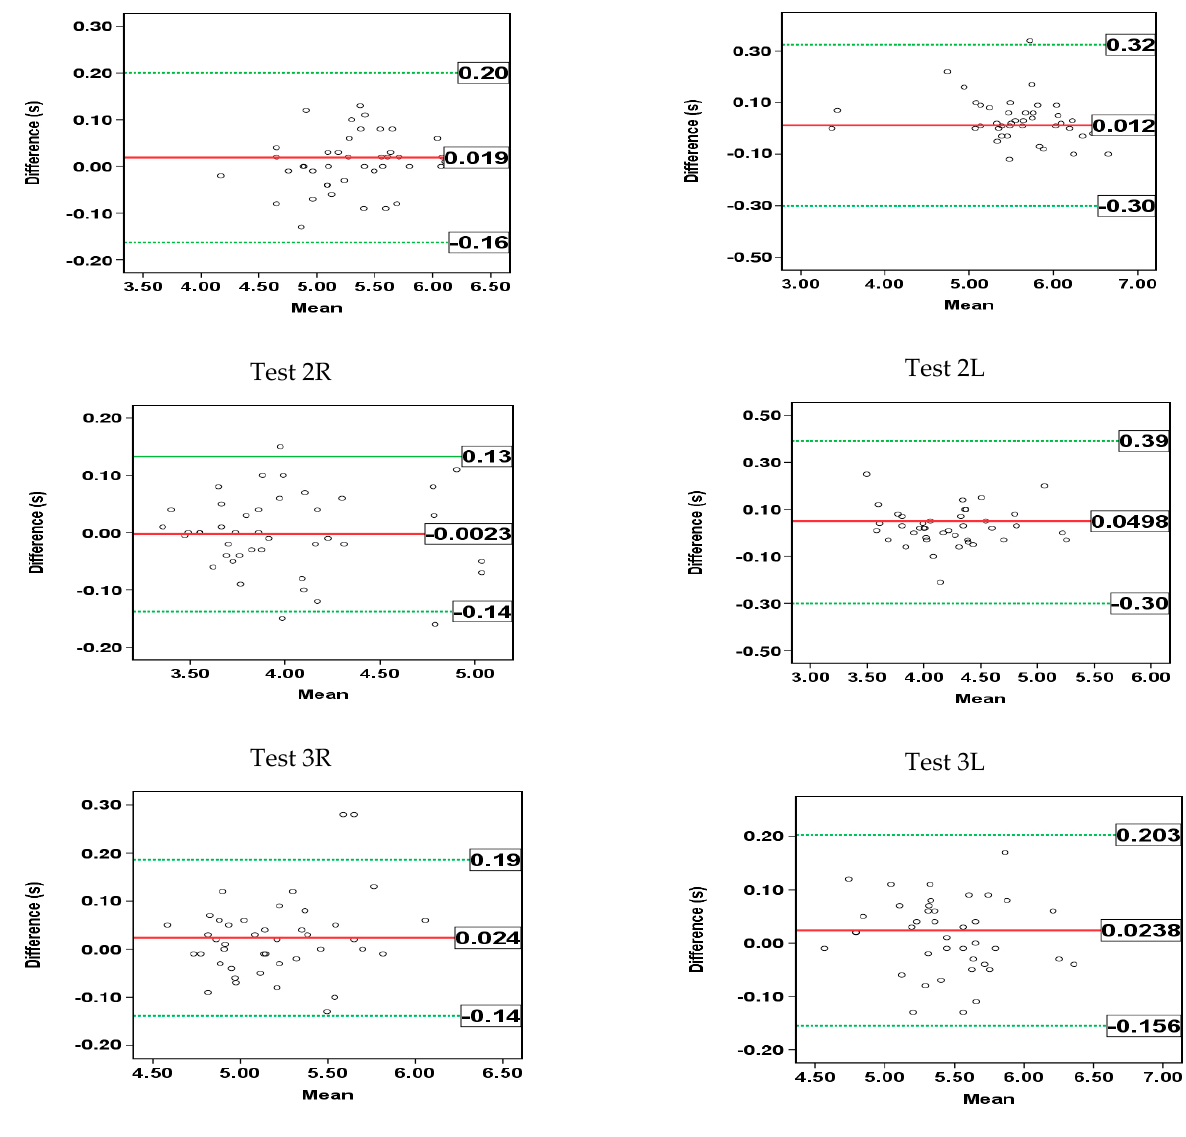
Figure 7. Limits of agreement levels according to the Bland–Altman method for the estimated tests’ run times between FitLight Trainer and IMU device for all four tests and both active